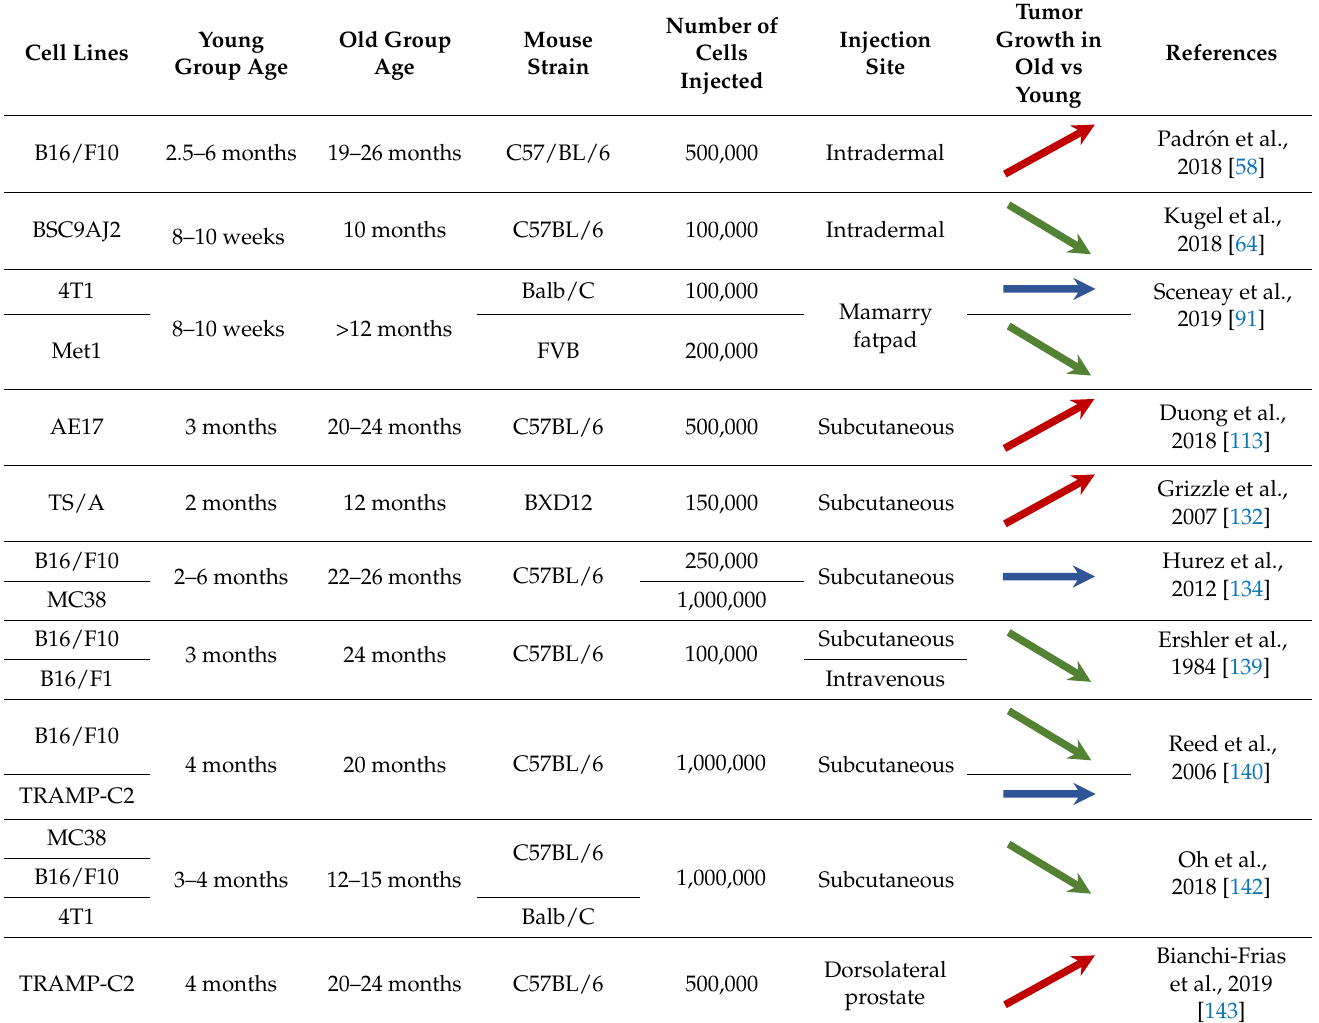
Table 1. Comparison of the tumor growth rate in young and aged mice.